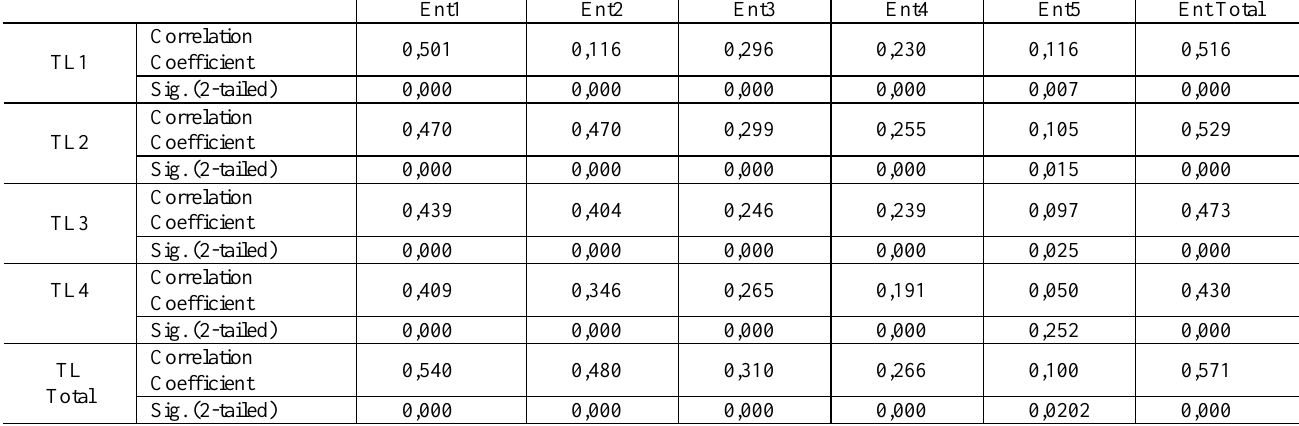
Table 8: Correlation matrix for the dimensions of Entrepreneurship and Transformational